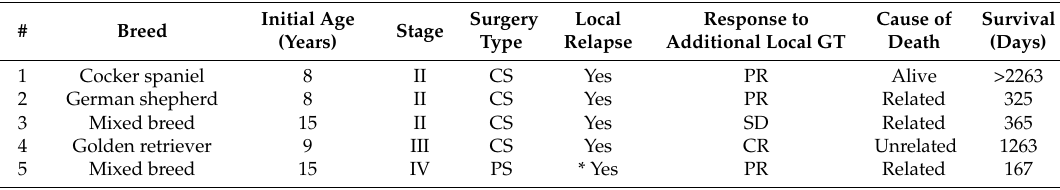
Table 5. Outcome of an additional local treatment for local